Question: Does the plotted quantity increase or decrease?
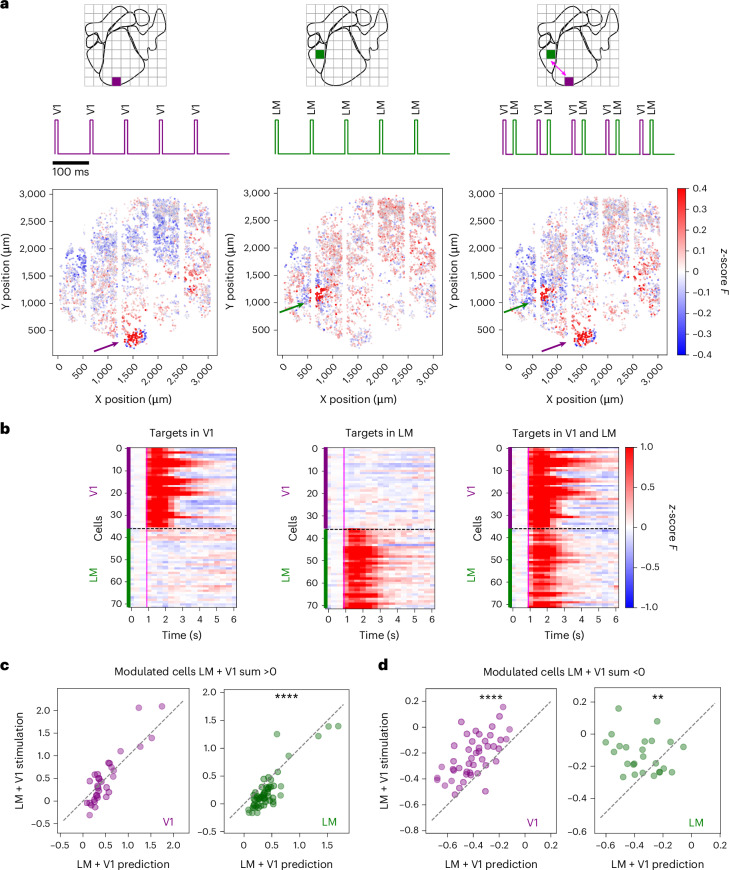
Answer: increasing